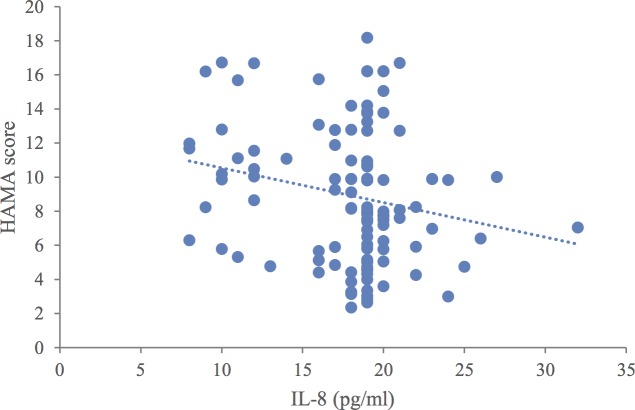
Relationships between interleukin (IL)-8 levels and Hamilton Anxiety Rating Scale (HAMA) scores.